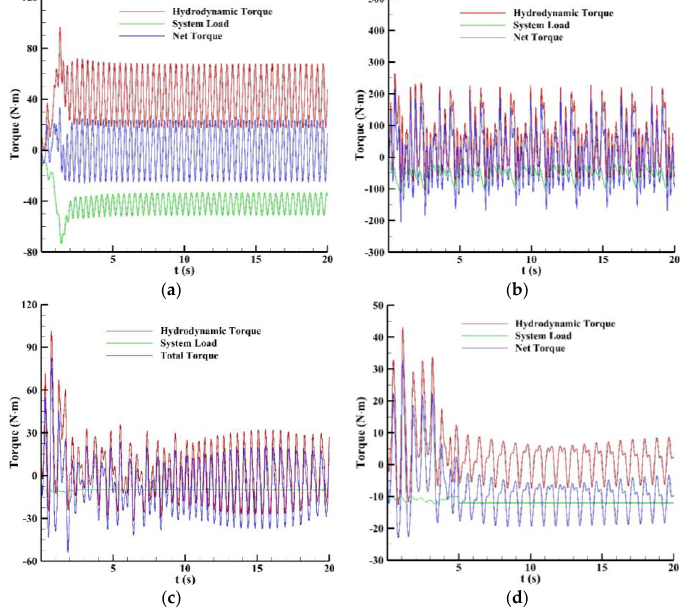
Figure 9. Time histories of torques during self-starting under the load conditions: ( a ) Stable Equilibrium Mode (SEM); ( b ) Unstable Equilibrium Mode (UEM); ( c ) Switch Mode (SM); ( d ) Halt Mode (HM).